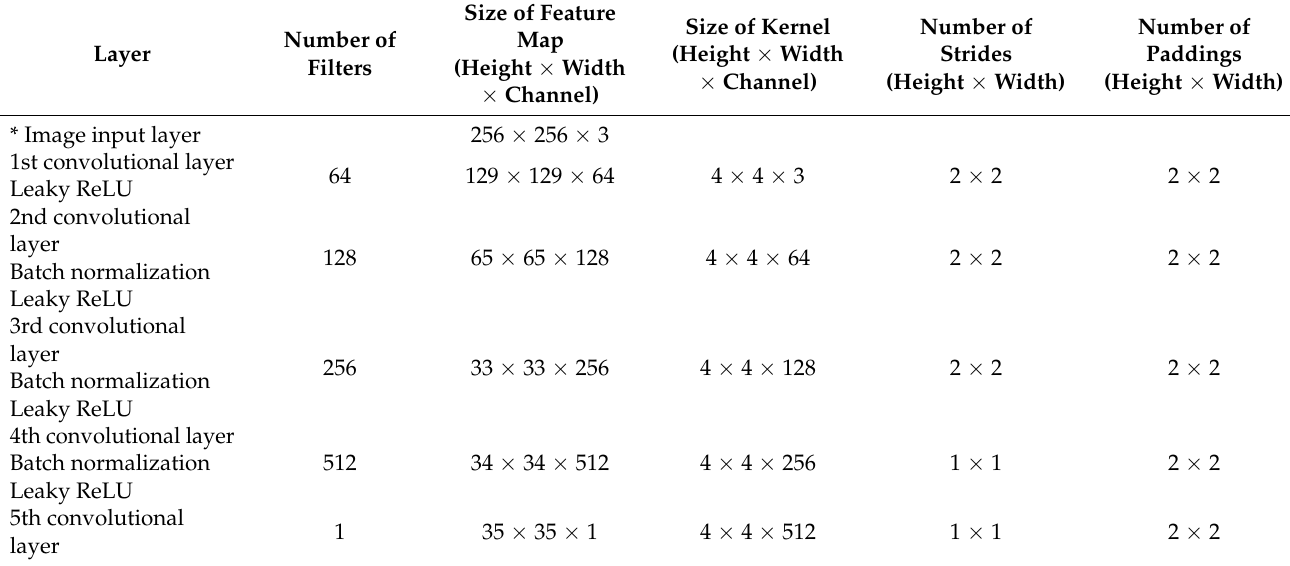
Figure 5. Discriminator of the modified DeblurGAN. Table 2. Descriptions of generator in modified DeblurGAN.